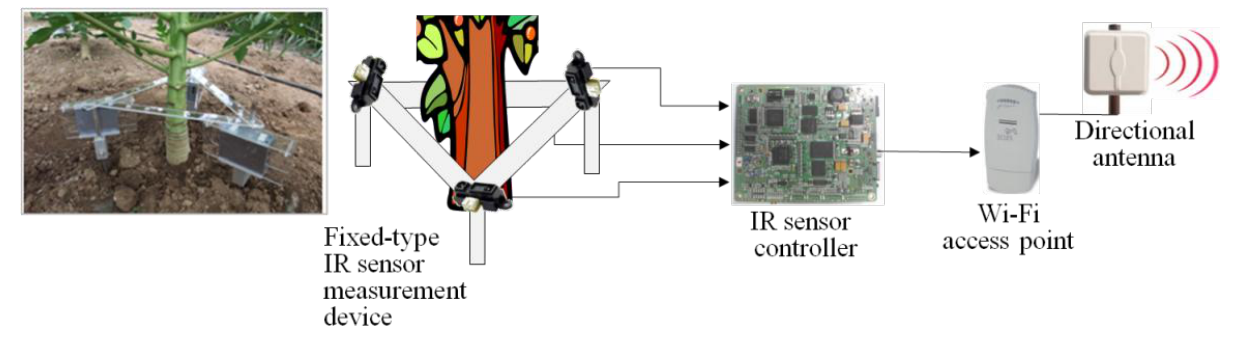
Figure 9. Fixed-type measurement